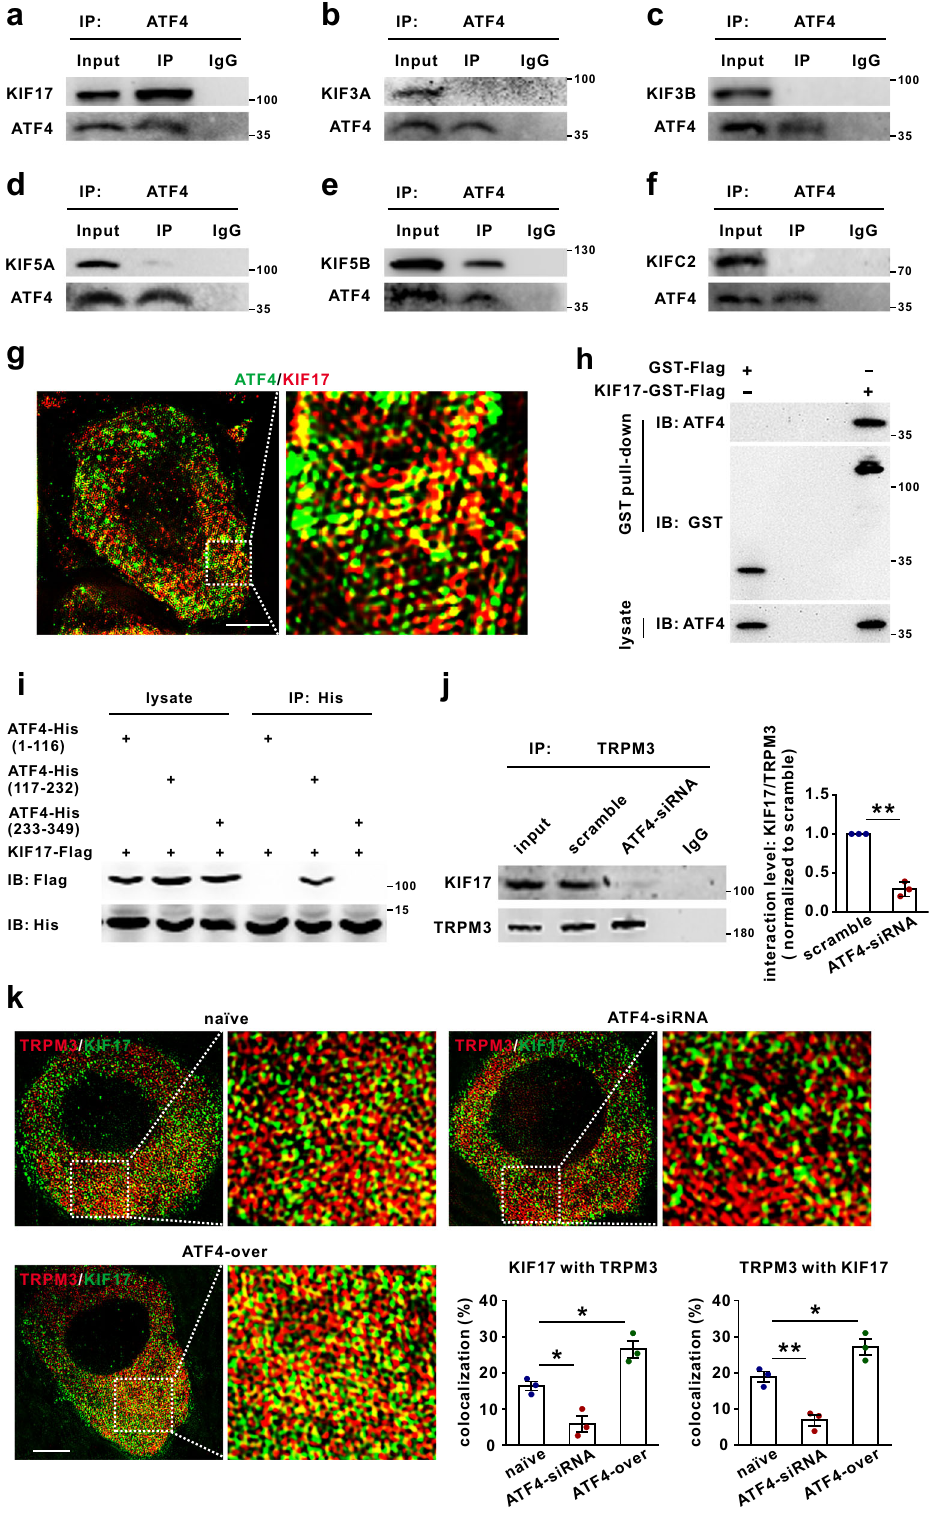
Cell culture and transfection . Mouse DRGs were freed from their connective tissue sheaths and broken into pieces with a pair of sclerotic scissors in DMEM/F12 (Gibco) at a low temperature. Following enzymatic and mechanical dissociation, the DRG neurons were plated on glass coverslips coated with poly- L -lysine (Sigma) in a humidi fi ed atmosphere (5% CO 2 , 37 °C). The cells were used for electro- physiological recordings approximately 4h to 24 h after plating. HEK293T